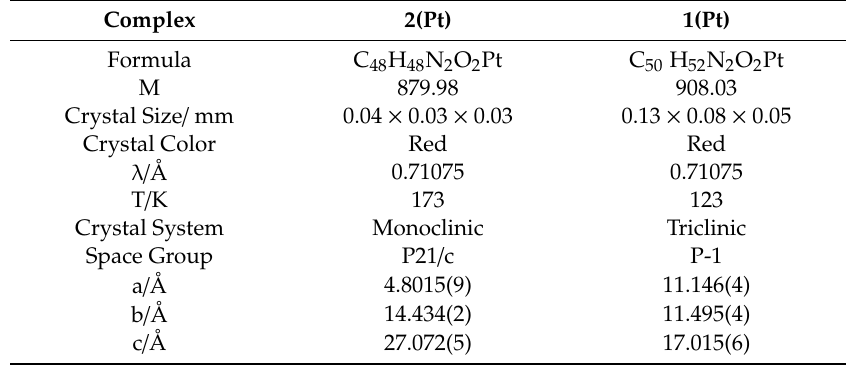
Table 4. Crystal data and structure refinement for the platinum complexes 2(Pt) and 1(Pt)